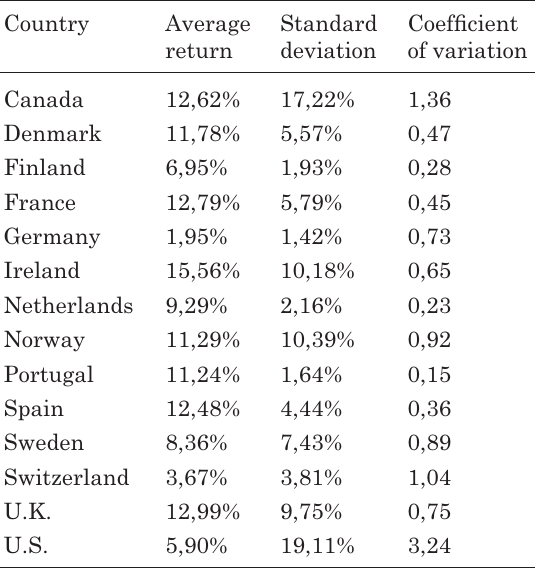
Table 7. Summary statistics of property data (unhedged returns)